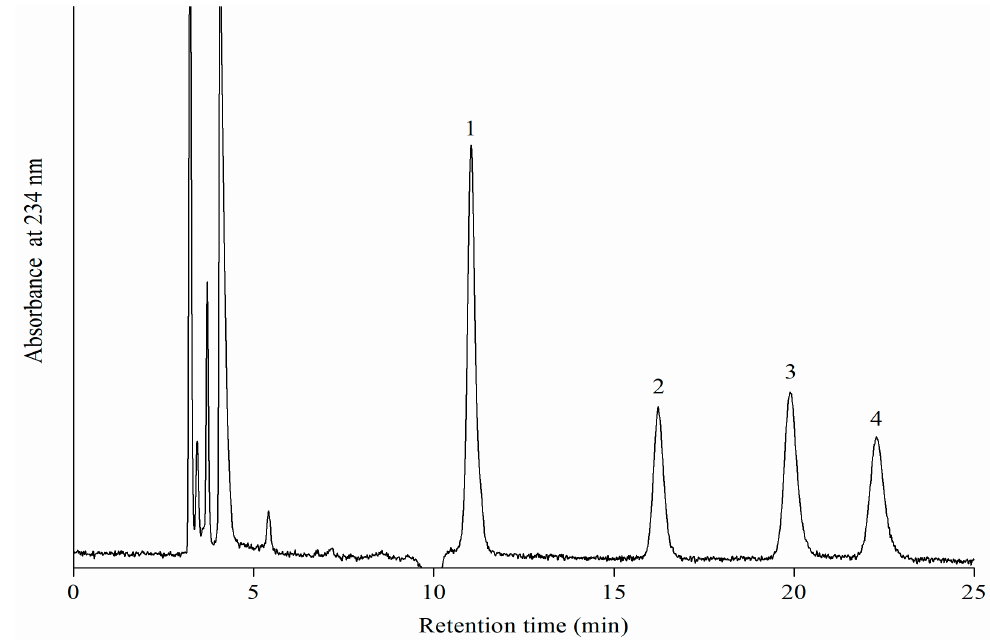
Figure 1. NP-HPLC chromatogram of reduced hydroperoxides from LA oxidation by recombinant porcine 12-LOXcd, peaks assignments: (1) 13- Z,E -HODE; (2) 13- E,E -HODE; (3) 9- Z,E -HODE; (4) 9- E,E -HODE.